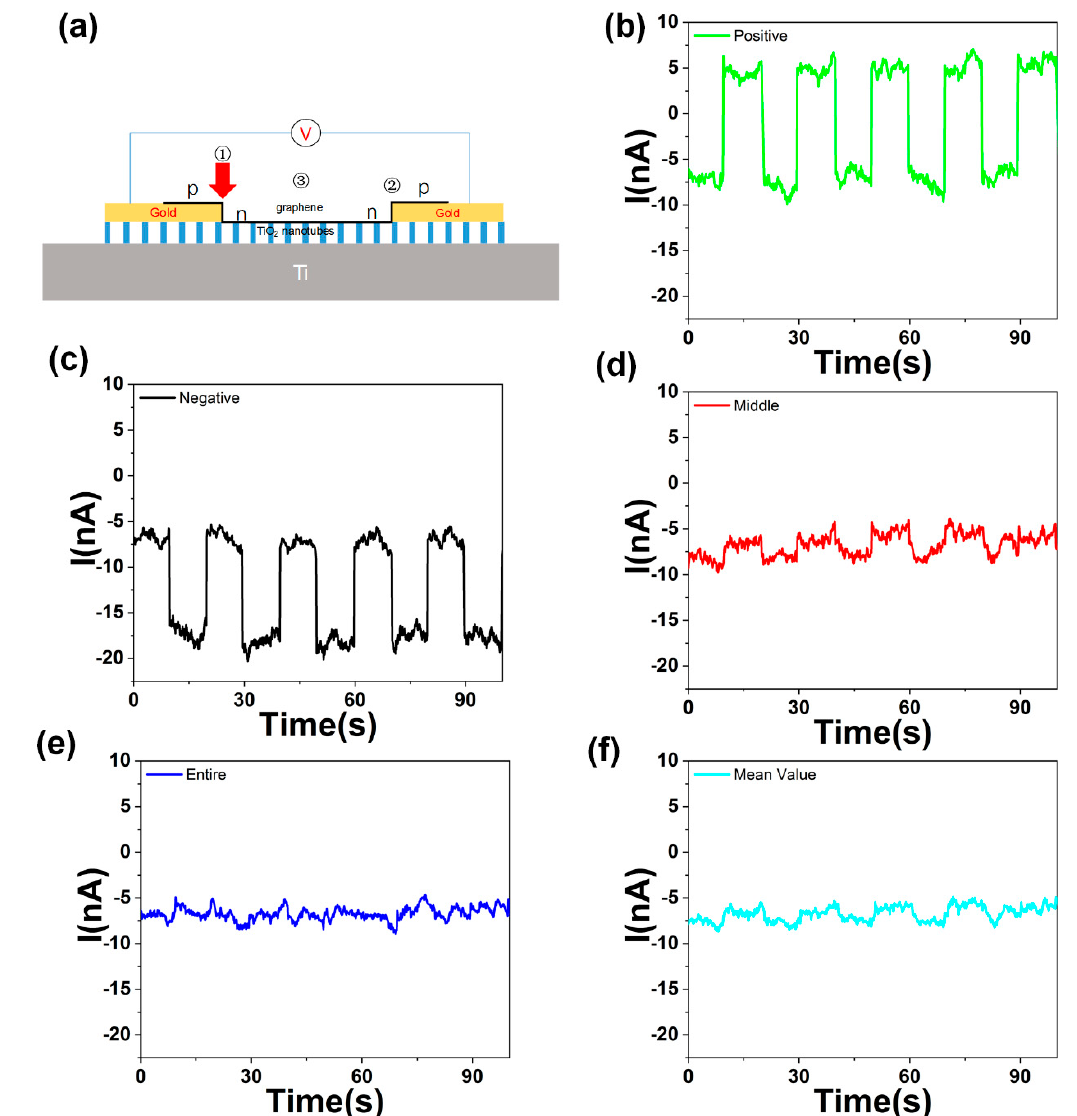
Figure 3. ( a ) Schematic of the photodetector. The monolayer graphene divided into three parts by the TiO 2 nanotubes and formed a horizontal p-n-p junction. The current changes when the laser focuses on the different area of the photodetector. ( b ) Positive photoresponse of the device when light illuminating on area 1. ( c ) Negative photoresponse of the device when light illuminating on area 2. ( d ) Photoresponse with the laser illuminated in the middle area 3 of the device. ( e ) Photoresponse with the laser illuminated on the entire device. ( f ) Mean value of the positive and negative photocurrent with 650 nm light illuminating.